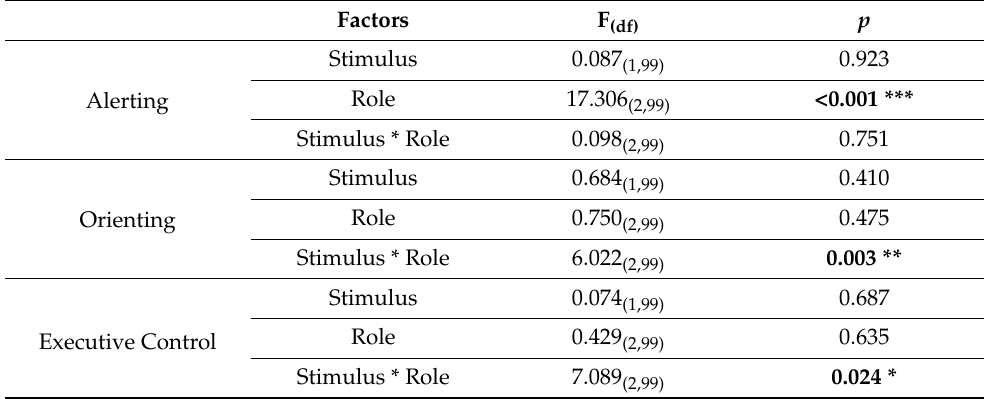
Table 3. The 2 × 3 mixed ANOVA outputs for Acc. Bold values represent significant (* p < 0.05; ** p < 0.01; *** p < 0.001)